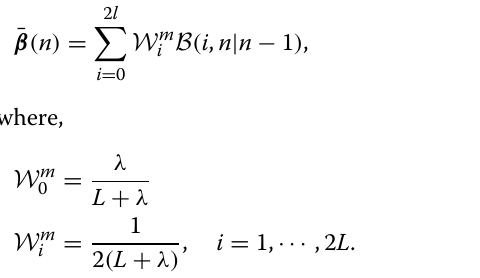
Algorithm 1 summarizes the UKF joint channel and PN estimation